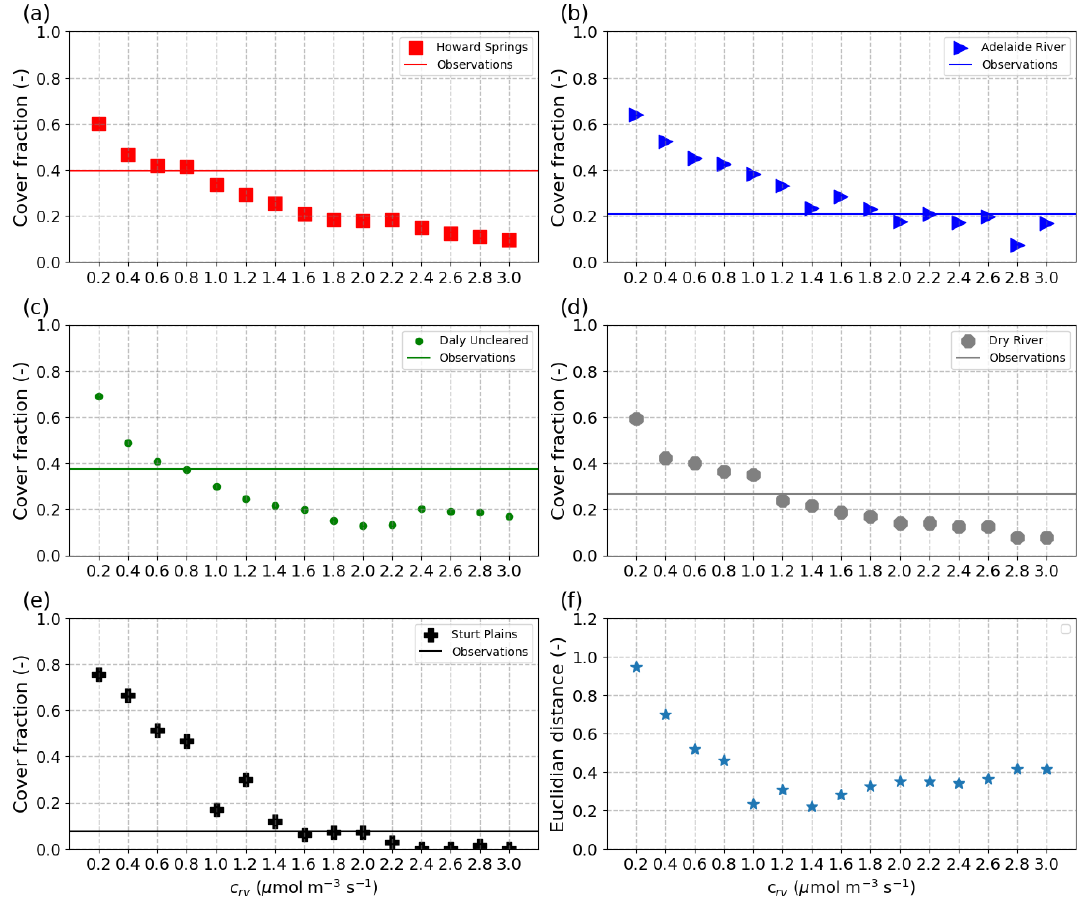
Figure 5. Simulated dry season percentage vegetation cover at each site (a–e) and the Euclidian distance of errors between sites (f) as a function of the water transport system cost factor ( c rv ). Symbols illustrate simulated vegetation cover of perennial vegetation ( M A , p ), while solid lines illustrate the perennial tree cover derived from observations, as described in Sect. 2.3.3. The Euclidean distance in panel (f) was based on the error between observed and simulated vegetation cover during the dry season for all five study sites, i.e. ED = E i the error for each site for a given c rv